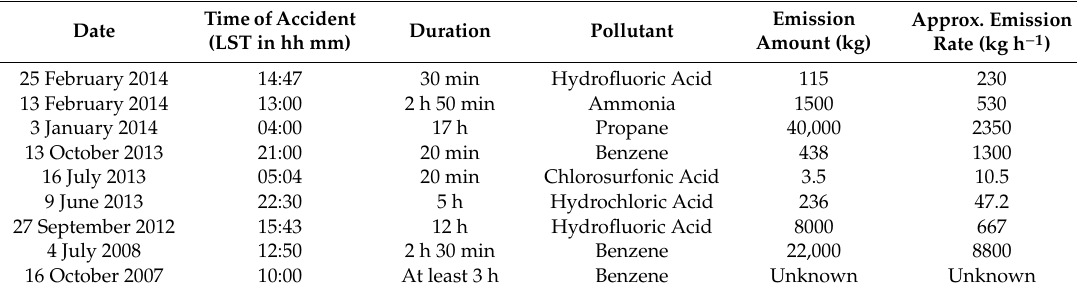
Table 2. A history of past chemical accidents that occurred in Ulsan,